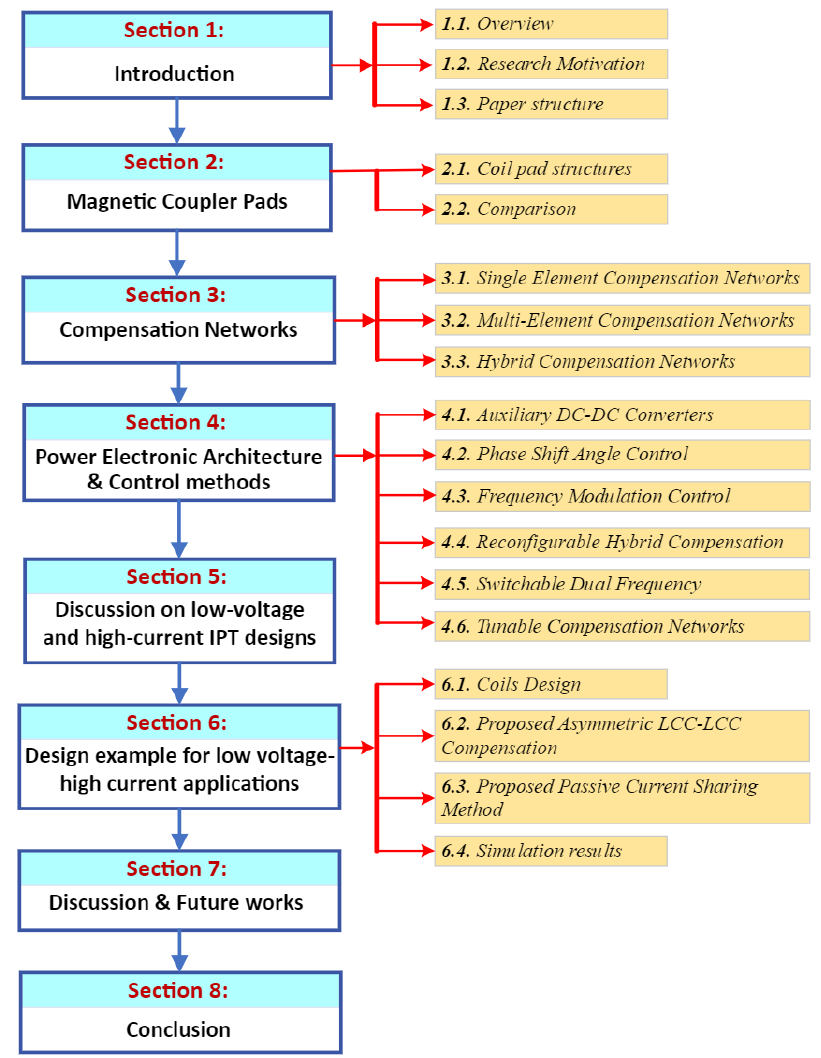
Figure 3. The organizational structure of this paper.